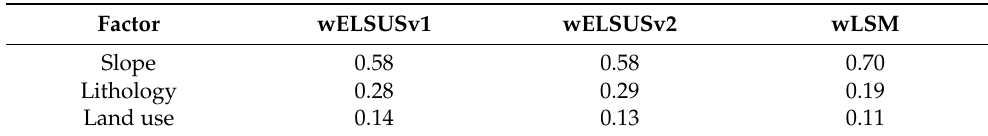
Table 6. Weight (“w”) assigned to factors according to ELSUS v1 and v2 and the approach adopted in this article (wLSM).